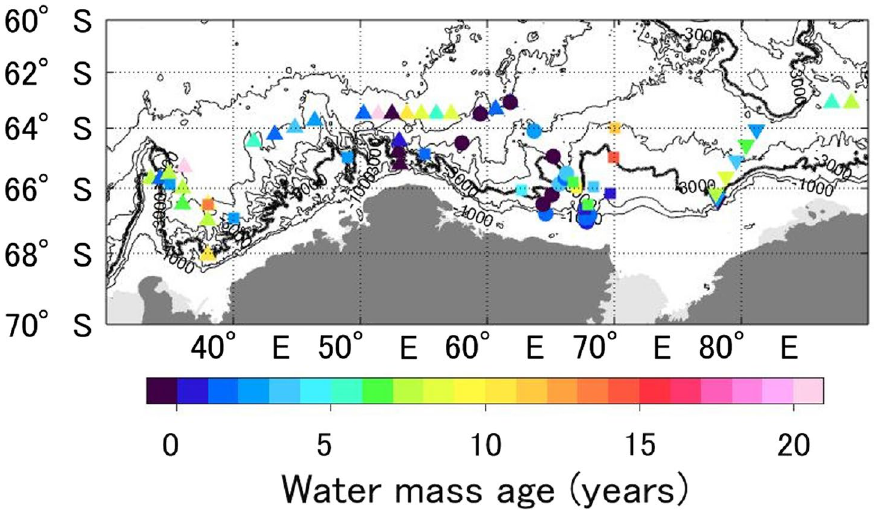
Figure 6. Spatial distribution of bottom AABW ages (neutral density: γ n > 28.27 kg m −3 ) (mean of observations within 100 m of the bottom). The symbols used are the same as in Fig. 1. Black contour lines represent isobaths at 1000 m intervals from 1000 to 3000 m and at 500 m intervals below 3000 m. The 3000 m isobath is indicated by the thick black line. The figure was generated using MATLAB (version R2021a; https:// www. mathw orks. com/ produ cts/ matlab. html) and the M_Map toolbox (http:// www. eoas. ubc. ca/ ~rich/ map.